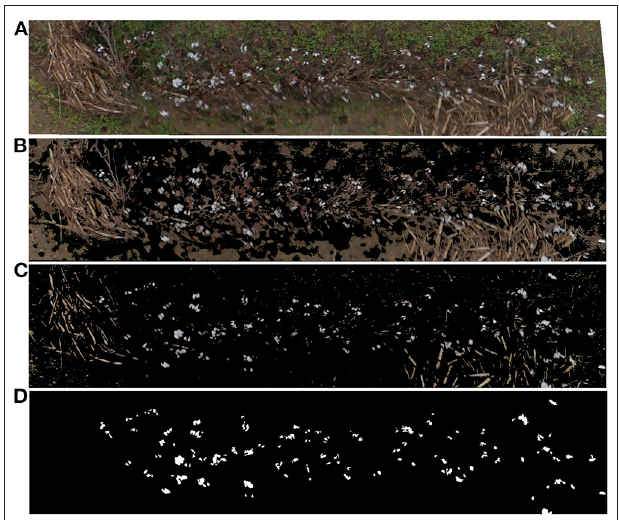
FIGURE 6 | Feature selection analysis. Feature importances obtained using random forest algorithm for feature selection. Blue bars represent the importance of each feature in the classifier model. L*, a*, and b* refer to the CIELAB color space